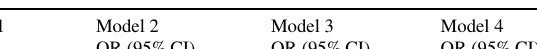
regression analysis associated with being